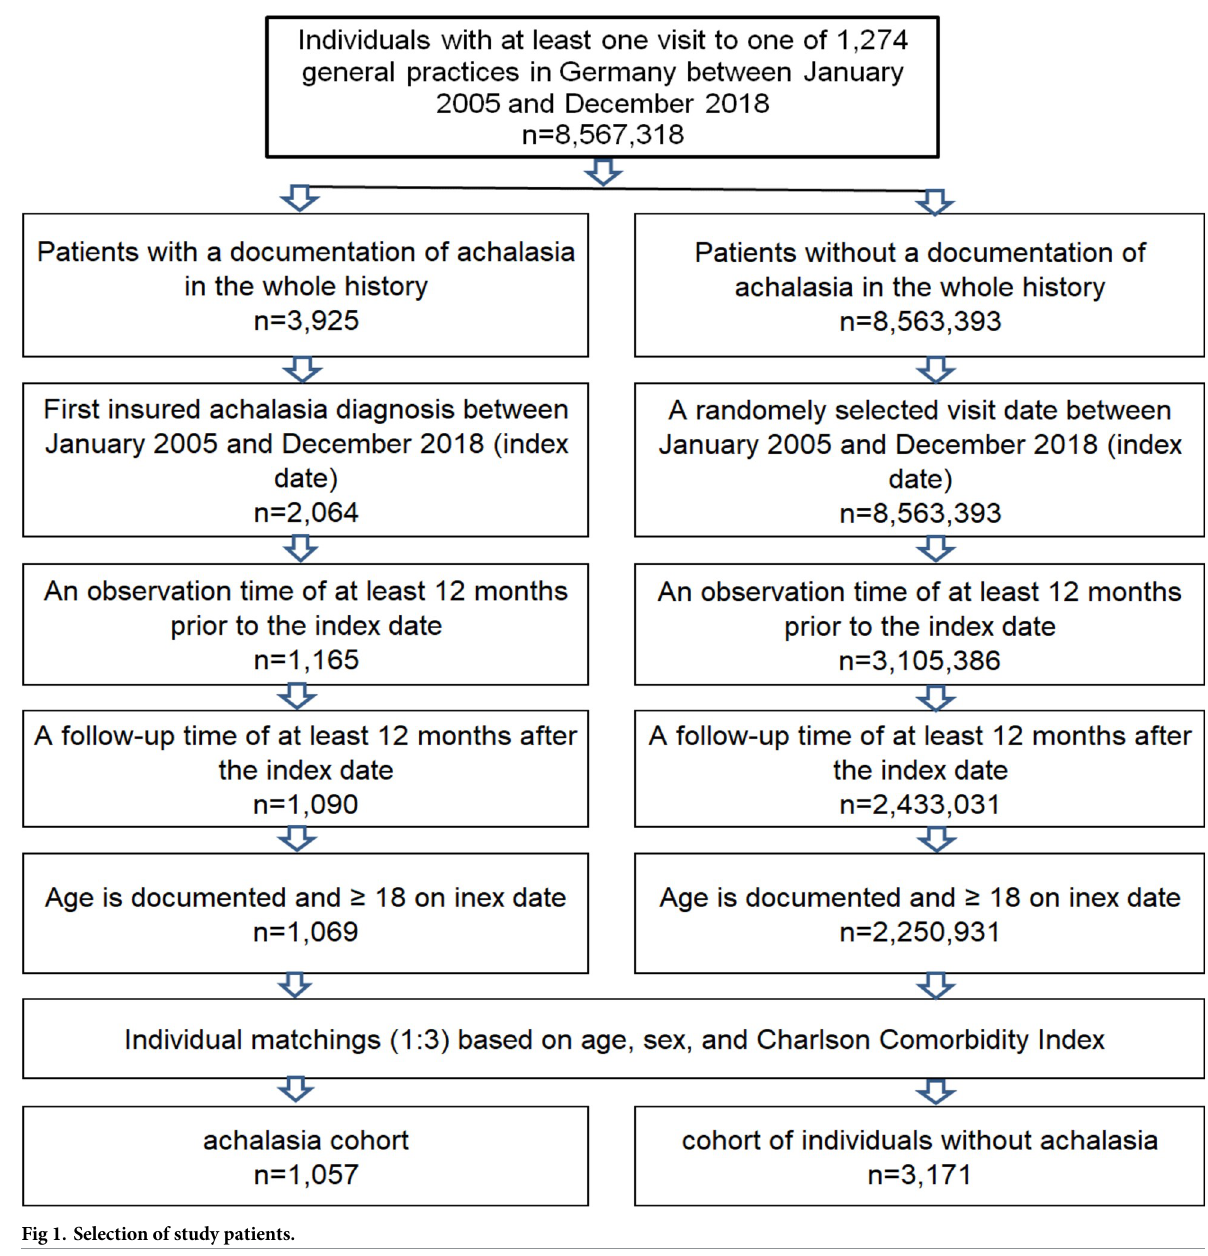
Fig 1. Selection of study